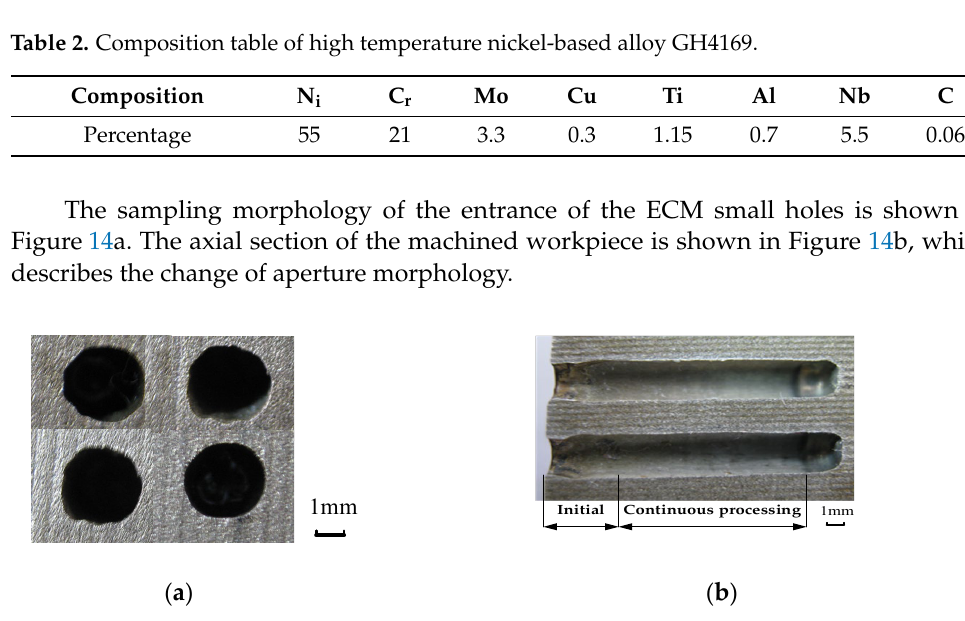
Figure 14. The morphology of the machined holes; ( a ) profile of small holes inlet end; ( b ) profile of keyhole section.